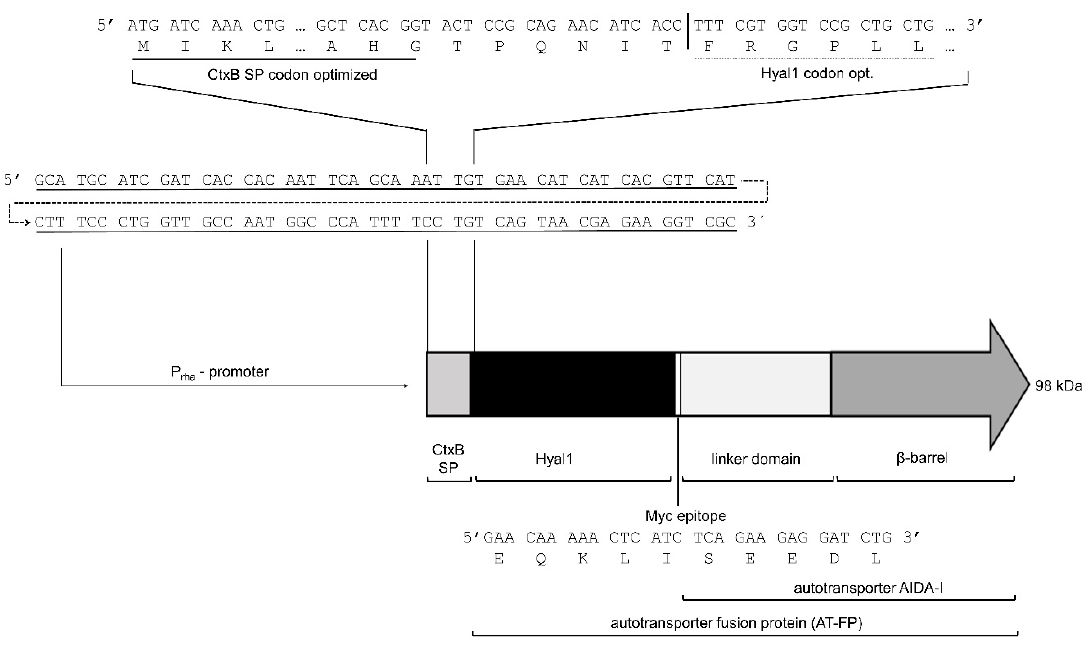
Figure 1. Schematic description of main features of pAIDAI rha -Hyal1 expression vector. DNA and amino acid sequences are given for parts of cholera toxin β -subunit signal peptide (CtxB SP), Hyal1 and the myc epitope, as well as the DNA sequence of the P rha promoter used for inducible expression. E. coli host strain F470 without plasmid as well as E. coli F470 carrying the plasmid pAIDAI rha